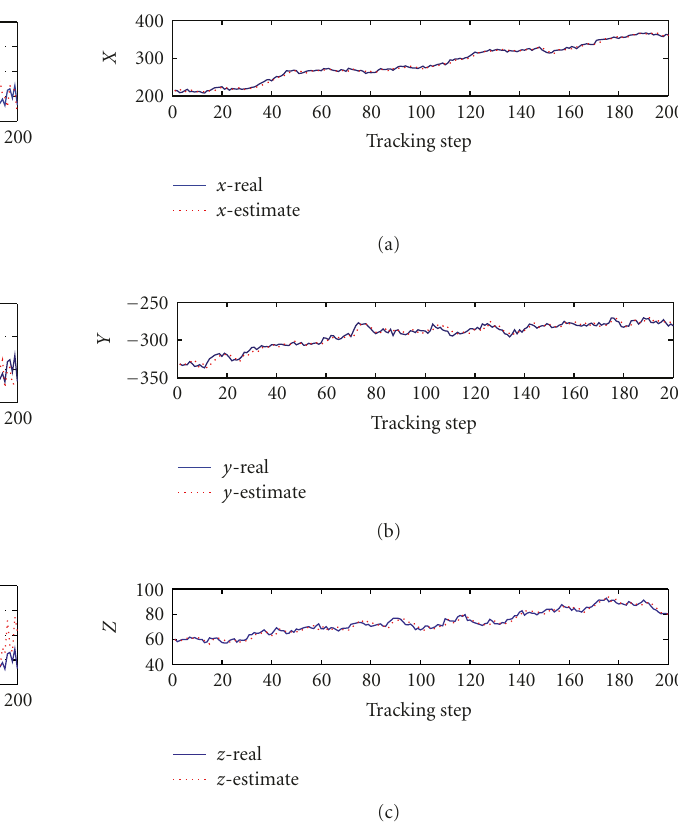
Figure 4: Comparison of global and local 3D estimation errors.